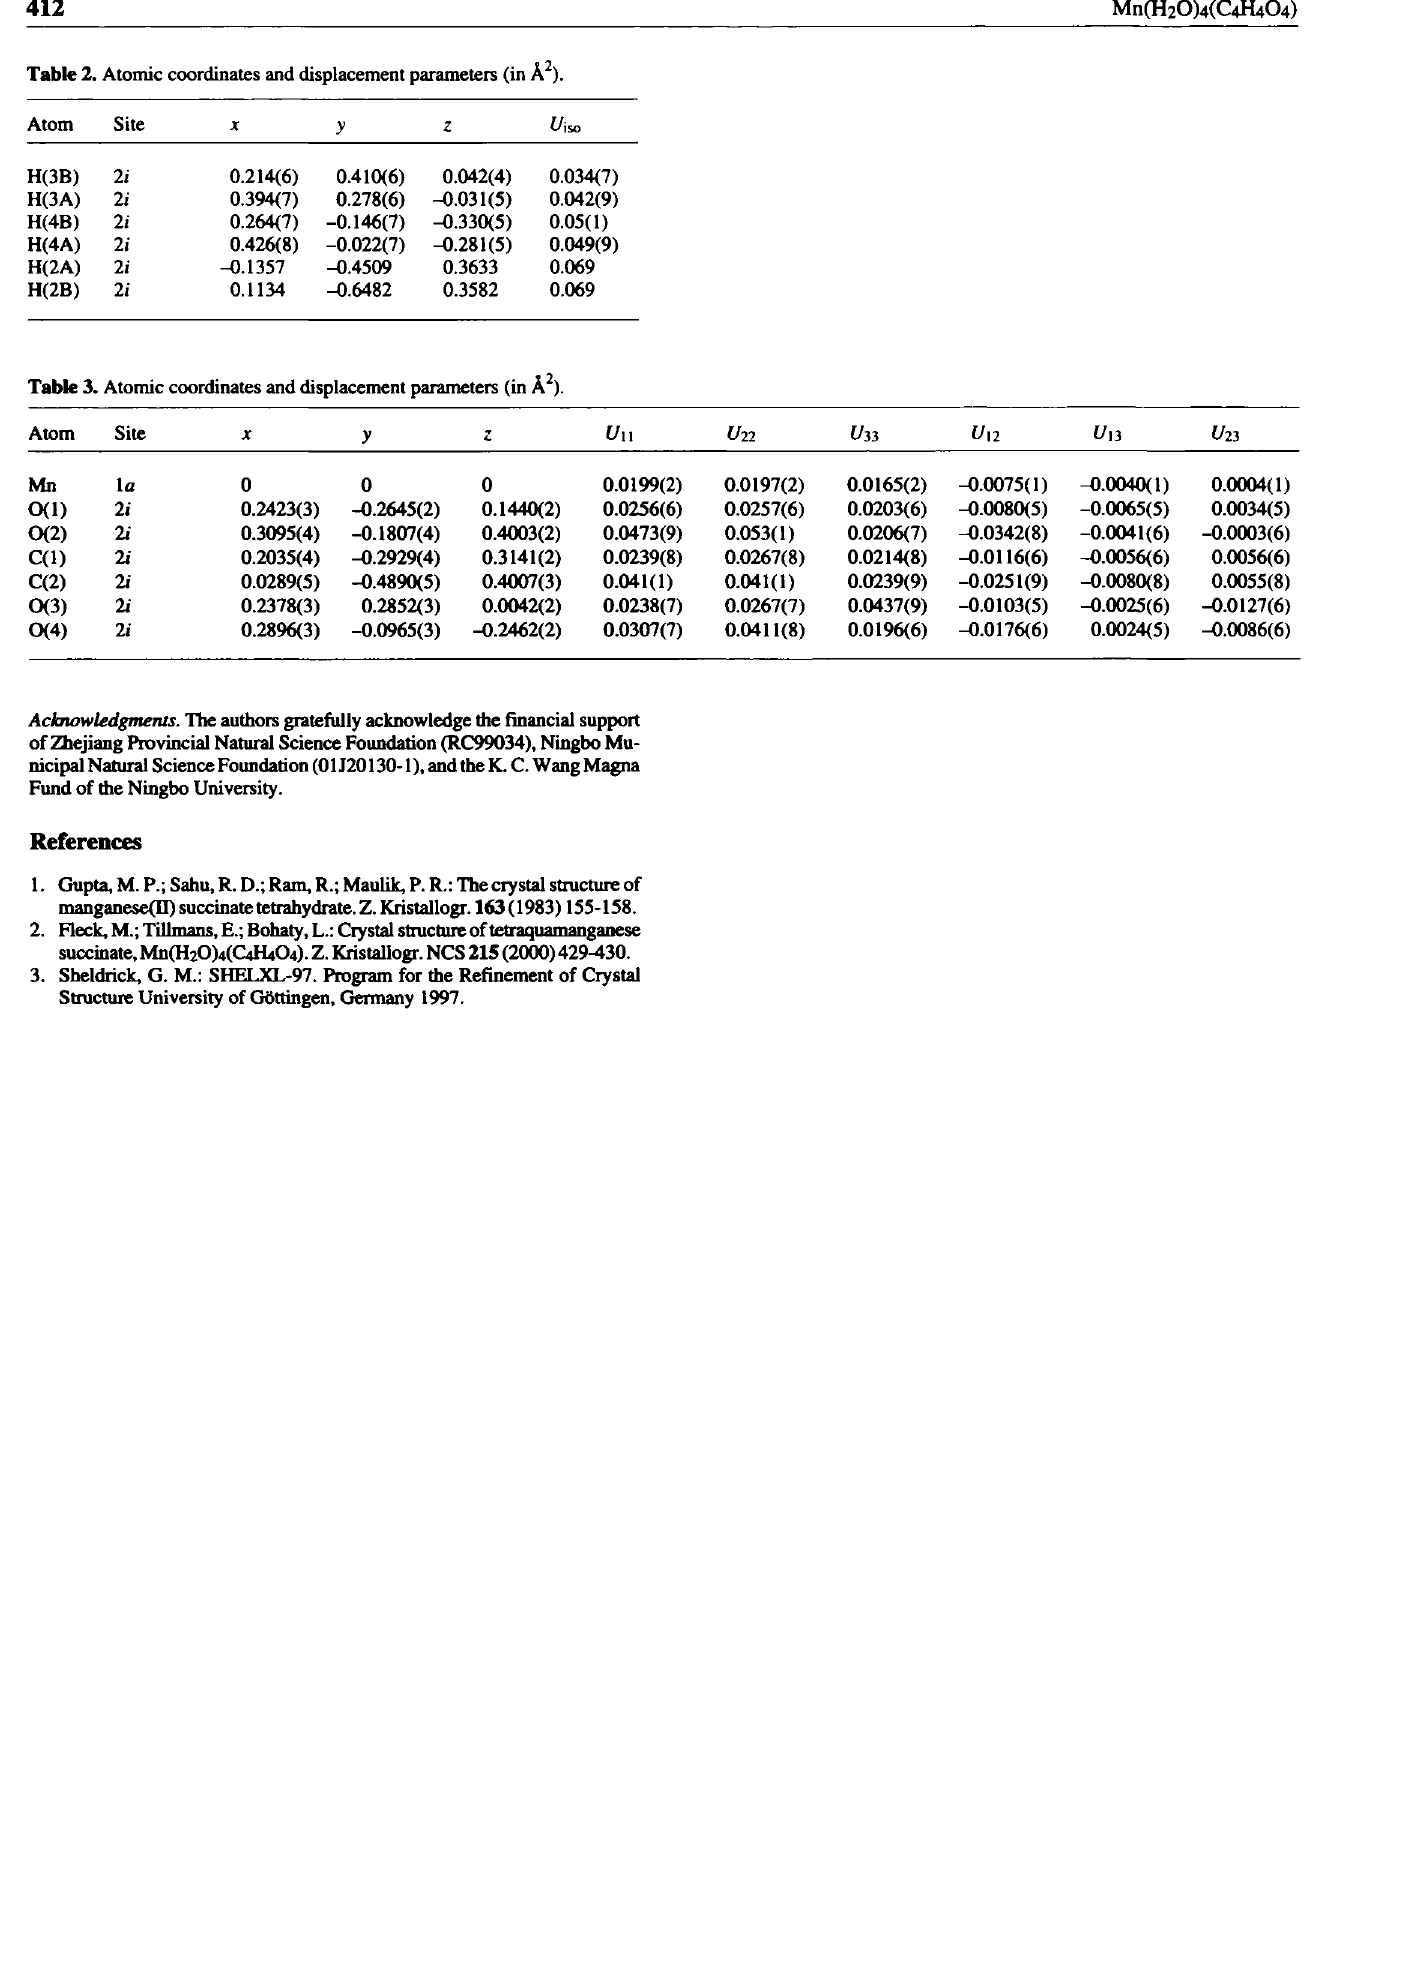
Table 2. Atomic coordinates and displacement parameters (in Â 2 ).